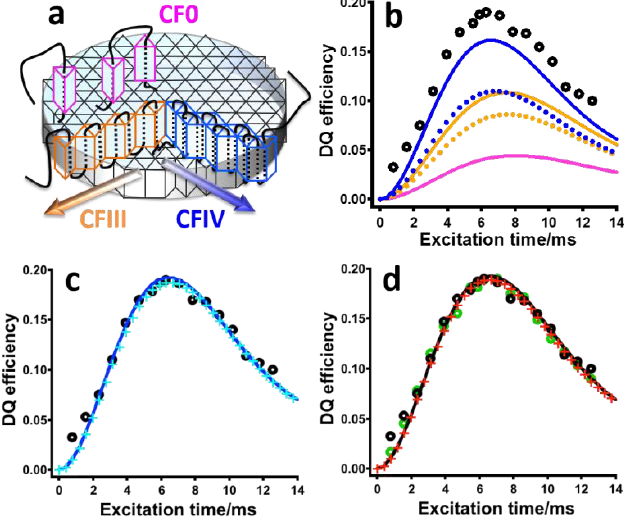
Figure 6. Schematic illustrations of ( a ) the circular crystal crystallized in dilute solution at ~0 °C and three possible chain-folding structures of CF0, CFIII, and CFIV. ( b – d ) The black and green open circles represent the experimental DQ buildup curves for 13 C-labeled i PB1 chains in the crystal blends with non-labeled chains (1/9) crystallized at ~0 and 60 °C, respectively. ( b ) The simulated DQ curves for CFIII (orange) and CFIV (blue) with < n > = 10 and < F > = 80% (solid line) and < n > =5 and < F > = 50% (dots) and for CF0 (pink solid curve). ( c ) Blue solid curve is simulated on the basis of CFIV < n > = 21 and < F CFIV > = 95%, and the curve composed of sky blue crosses is simulated on the basis of < n > = 8 and < F CFIV > = 100%. ( d ) Red crosses and black solid curve are the simulated curves for CFII with < n > = 21 and < F CFII > = 90%, and < n > = 8 and < F CFII > = 100%, respectively. (Reprinted with permission from